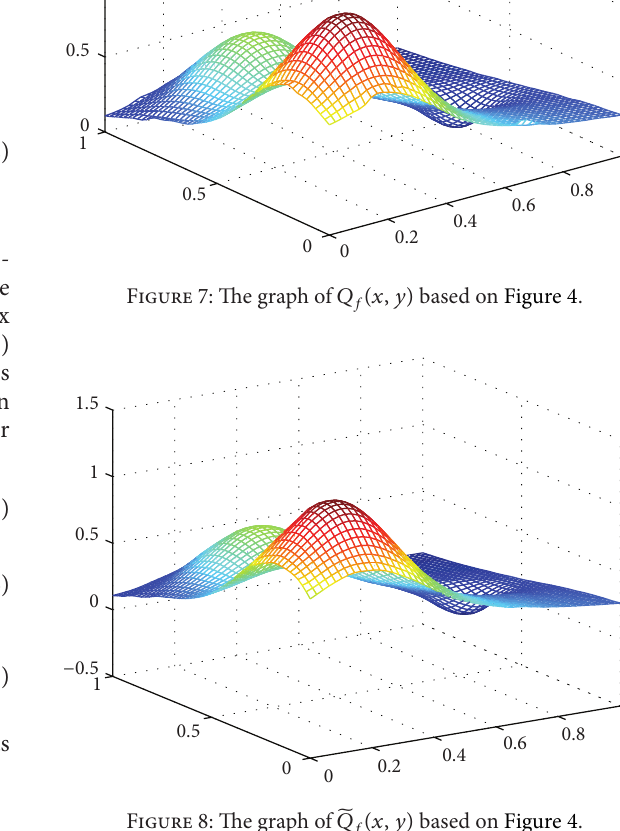
Figure 8: The graph of